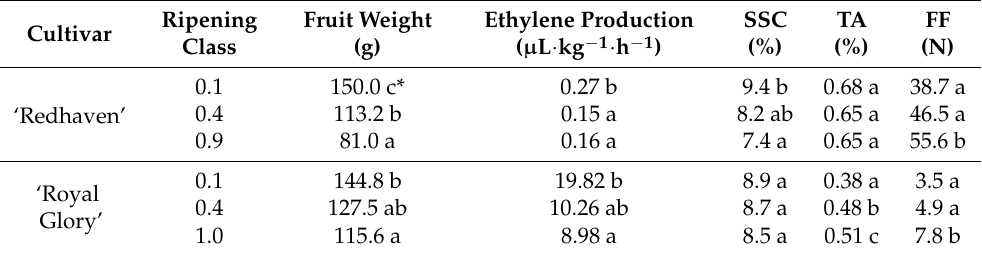
Table 1. Fruit weight, ethylene production, total soluble solid content (SSC), titratable acidity (TA), and fruit firmness (FF) of ‘Redhaven’ and ‘Royal Glory’ peaches belonging to various ripening classes. Cultivar